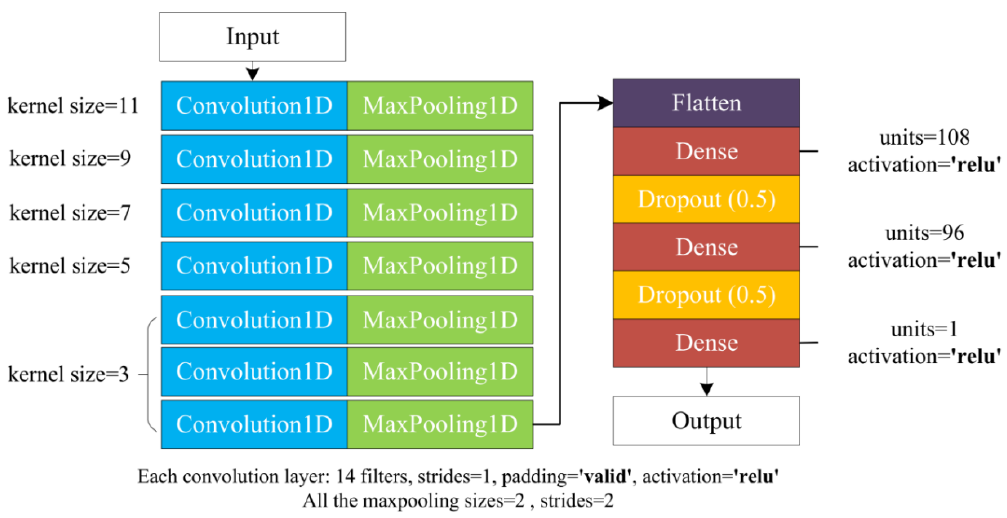
Figure 12. The architecture of the adopted the CNN model.